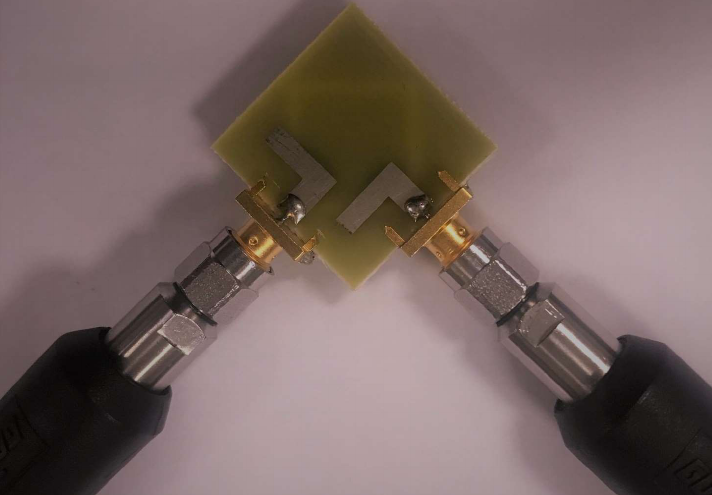
Figure 6. Radiation, total efficiencies, maximum gain of the diamond-ring slot antenna.